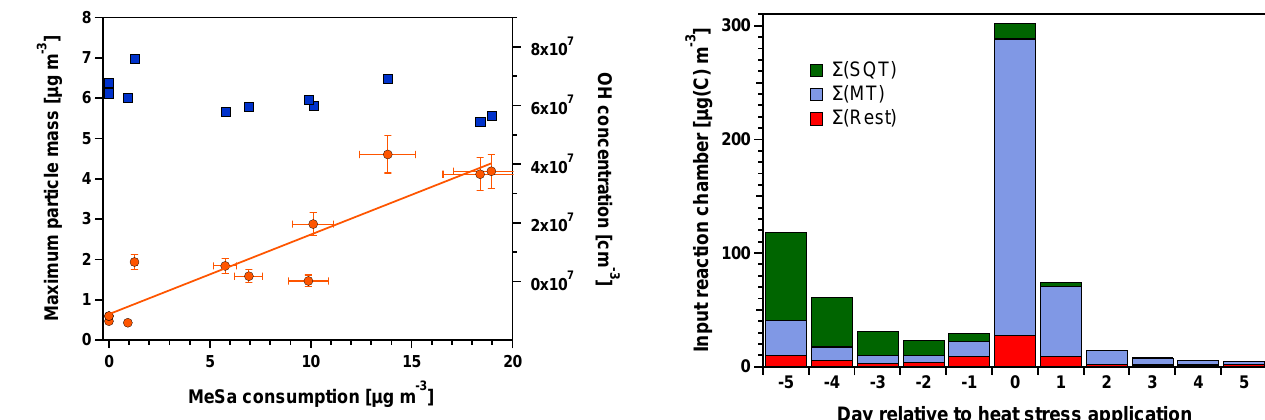
Fig. 4. BVOC concentrations of Experiment #2 at the inlet of the reaction chamber as determined for the insect-infested spruce be- fore, during and after heat stress application (35 ◦ C on day 0 and 30 ◦ C on day 1). Data are the mean of 4 h before particle formation was induced in the reaction chamber. SQT = sesquiterpenes, MT = monoterpenes, Rest = phenolic BVOCs, GLV, and isoprene.